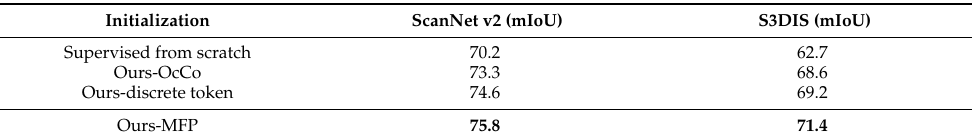
Table 10. Ablation studies on our proposed MFP pretraining method. The bold denotes the best performance.